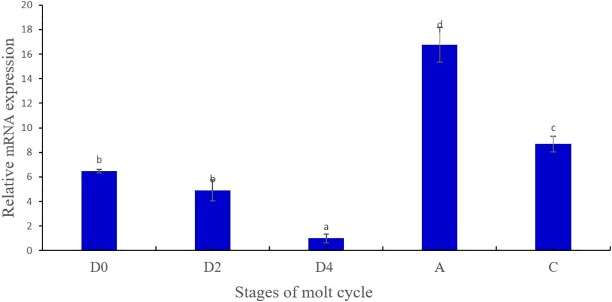
Mn-MIH expression during the molting cycle.Notes: D0-early pre-molt; D2-middle pre-molt; D4-late pre-molt; A-post-molt; C-inter-molt. Data were shown as means ± SD (standard deviation) of three separate individuals in the tissues. Bars with different letters were significantly different (P < 0.05).